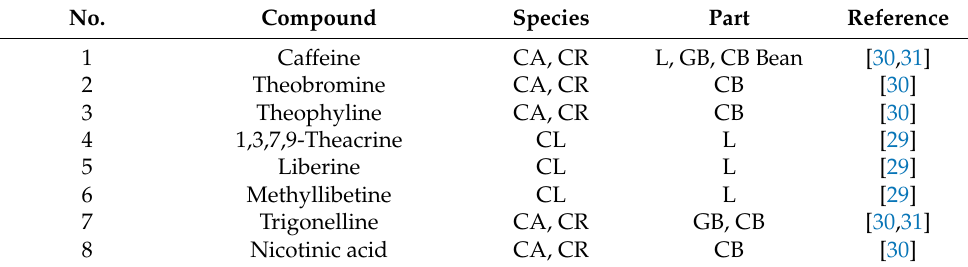
Table 2. Alkaloid compounds in coffee.